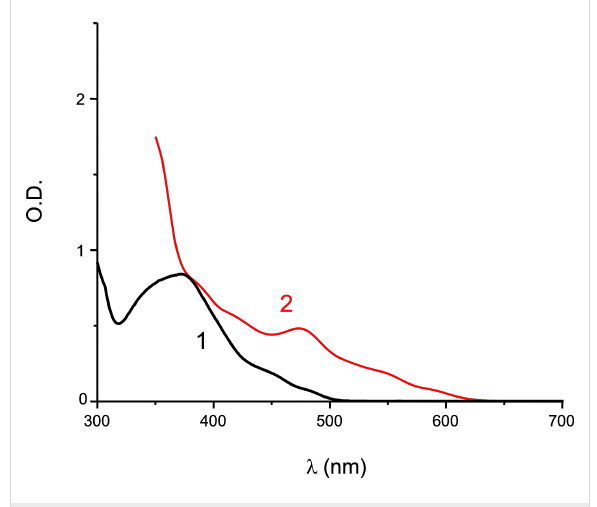
Figure 6: UV–visible light absorption spectra for Ir(piq) 2 (tmd) (2) and Ir(ppy) 3 (1); solvent: acetonitrile.